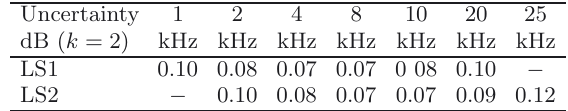
Typical uncertainty of free-field reciprocity calibration for experienced